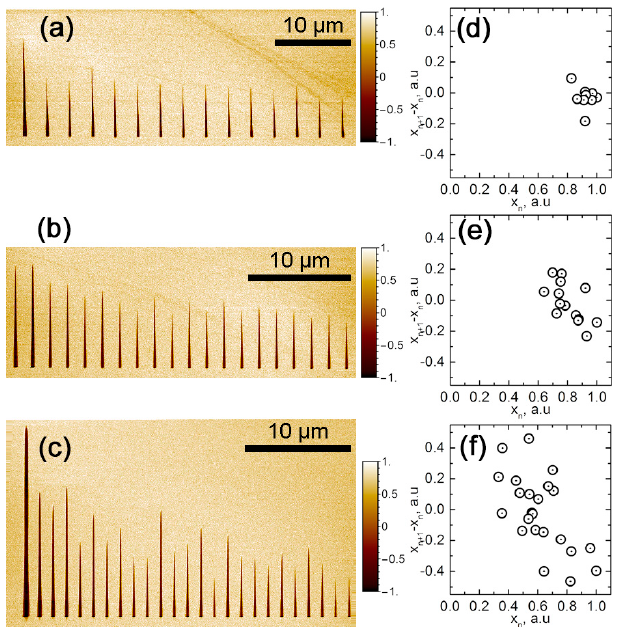
Figure 3. Domain arrays and plots of the difference in normalized lengths of neighboring n + 1 and n domains x n+1 − x n versus the normalized length of n domain x n for different spacing between the points of bias application: ( a , d ) 3 µ m; ( b , e ) 1.7 µ m; ( c , f ) 1.28 µ m. Pulse amplitude: 100